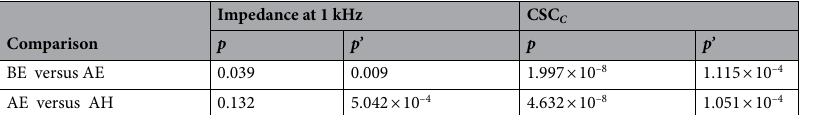
Table 1. One-tailed p -value using paired t-test. The impedance at 1 kHz and CSC C are compared after sequential treatments. Evaluations are made both with outliers (14 electrodes) and without outliers (8 electrodes). BE before electroplating, AE after electroplating, AH after hydrogel coating. p : p -value of all data; p ’: p -value of data with outliers